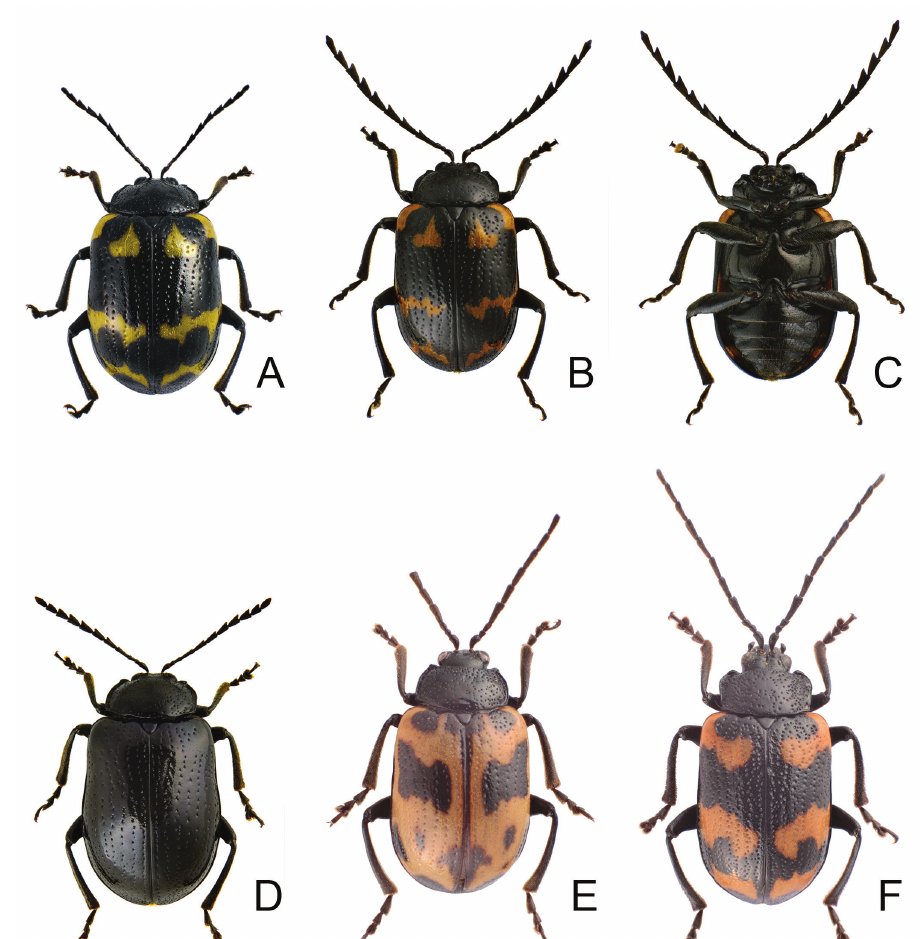
Figures 1. Habitus of Gallerucida bifasciata Motschulsky. A Female, dorsal view B Male, color variation, ventral view C Ditto, ventral view D Female, stripes completely reduced, dorsal view E Male, stripes well developed, dorsal view F Male, from northern